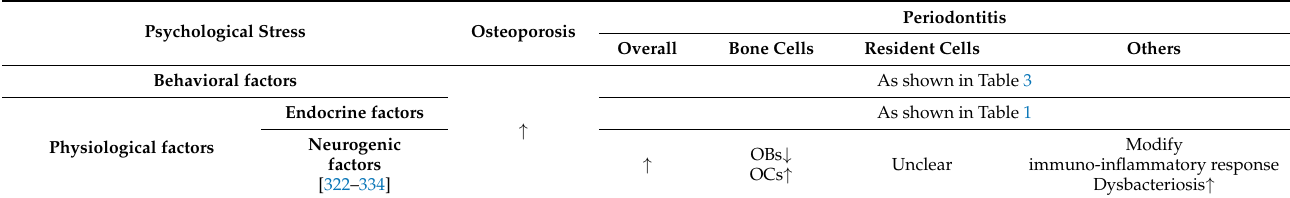
Table 4. Impact of psychological stress on osteoporosis and